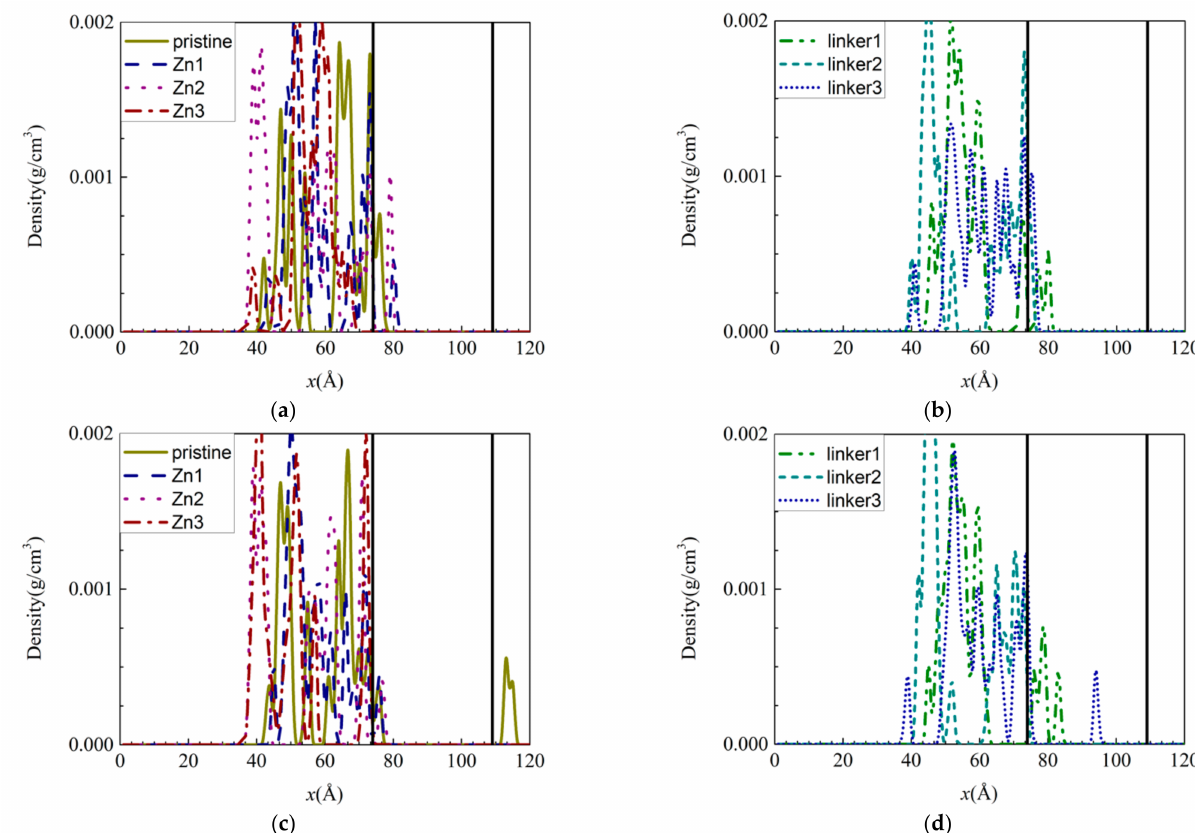
Figure 3. Density distributions of the ions along the x -axis inside the ZIF-8 membranes at the end of the simulation under the default operating conditions of 300 K: ( a , c ) Na + and ( b , d ) Cl − ions. The two ends of the membrane are delineated by vertical black solid